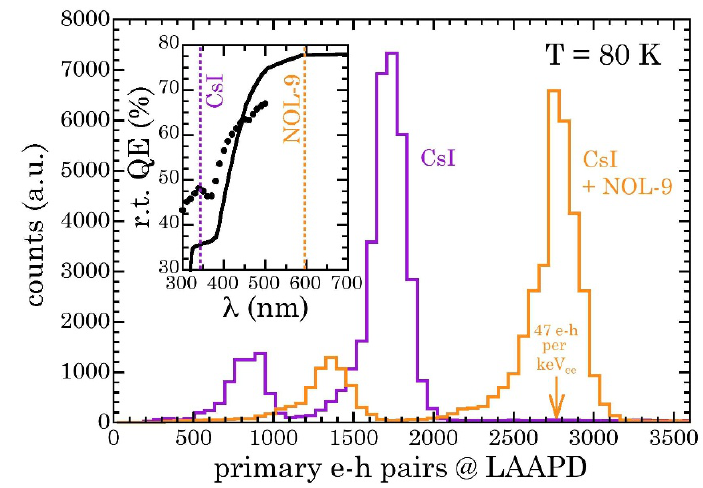
Figure 6 . Response of a 3.2 cm 3 cryogenic CsI crystal to 59.5 keV 241 Am gammas, seen by a 1 : 3 1 : 3 cm 2 LAAPD [72], with and without a NOL-9 wavelength shifter plate [73, 74]. Escape peaks (cid:2) appear at 55.5 keV and 29.7 keV. LAAPD gain and noise (G=1,060, 4 eV rms) were monitored via concurrent silicon surface irradiation with 55 Fe x-rays [59, 60]. Plasma e(cid:11)ects [75] and QE reduction with temperature [76] were considered. Inset: available room-temperature (r. t.) QE data from the LAAPD manufacturer (dots), and for a generic Si APD (line) [77], together with wavelengths of CsI emission (80 K, [58, 64]) and of NOL-9 r. t. luminescence [78]. The increase in photon detection is a 4.7 primary e-h signal, above LAAPD threshold (see